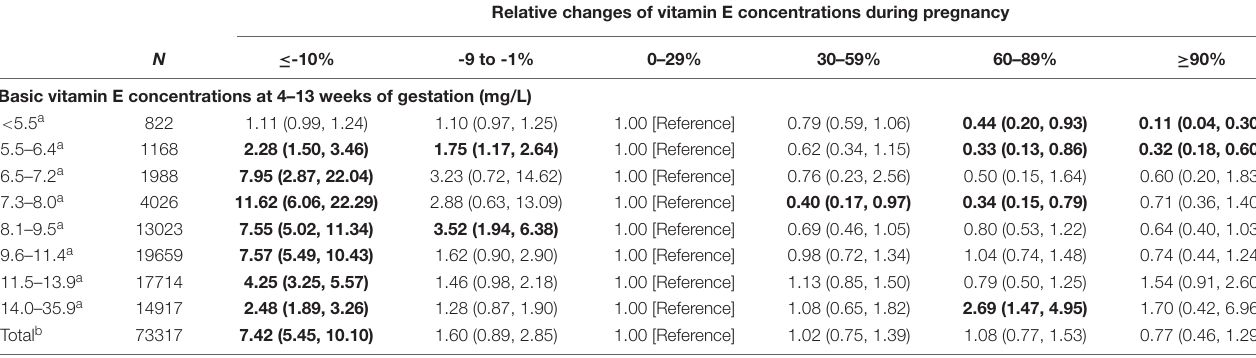
TABLE 3 | Adjusted relative risks (95% CI) for pre-eclampsia according to gestational vitamin E concentration changes stratified by vitamin E concentration categories in the first trimester. Relative changes of vitamin E concentrations during